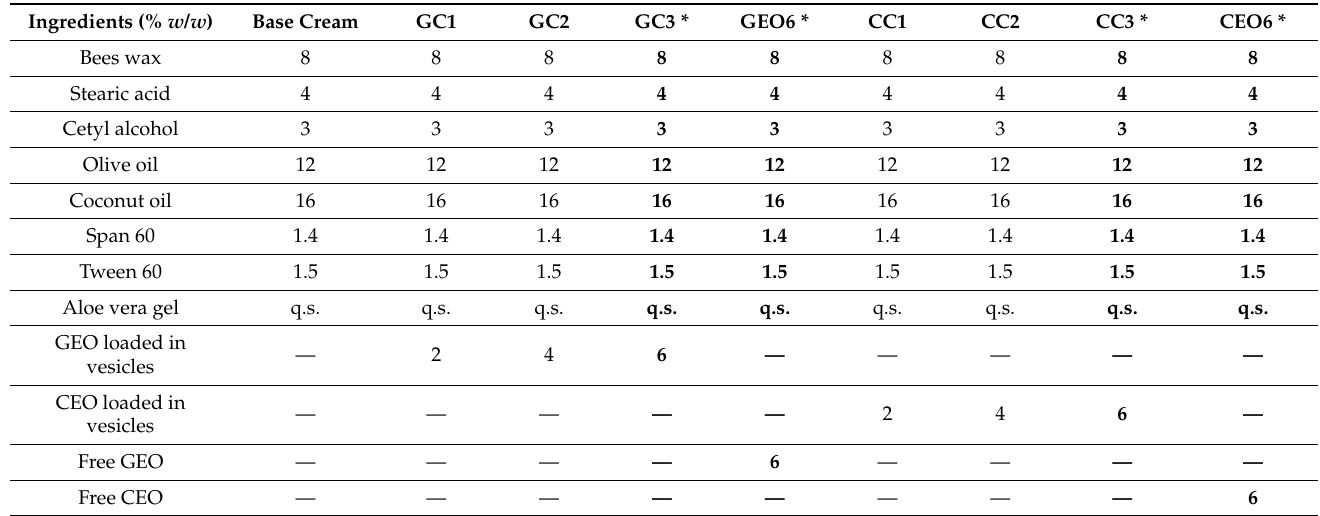
Table 1. Composition of various cream formulations, i.e., base cream; vesicular cream (GEO loaded: GC1, GC2, and GC3 and CEO loaded: CC1, CC2, and CC3); non-vesicular cream GEO6 and CEO6 for GEO and CEO, respectively [22].